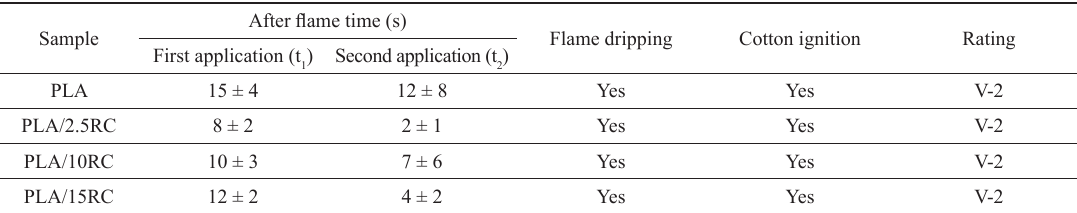
Table 1. Vertical burning test UL 94V results for PLA and PLA/RC composites.